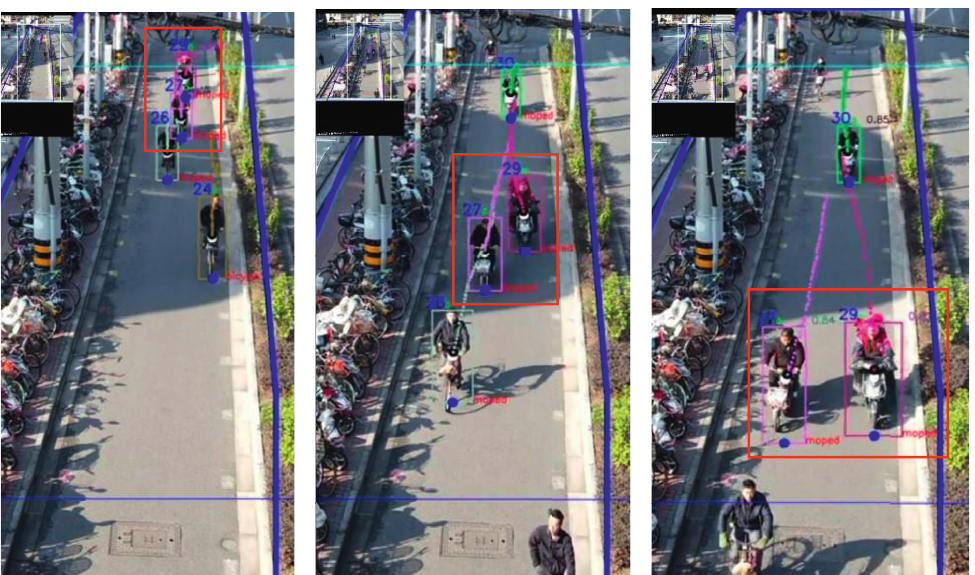
Figure 7: An overtaking event.